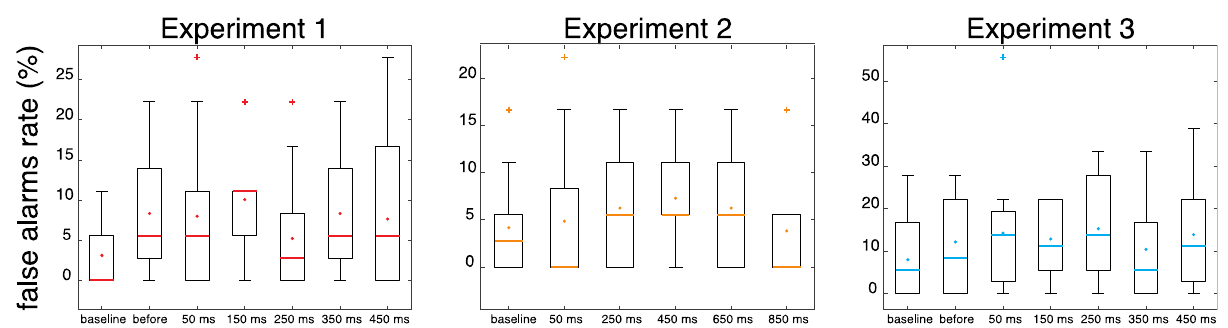
Figure 6. Boxplots with false-alarm rates for baseline and each probing moment in each experiment. The graphs show medians (colored lines), averages (colored dots in the box), inter-quartile range (box), most extreme data point that are not considered outliers (whiskers) and outliers (crosses).